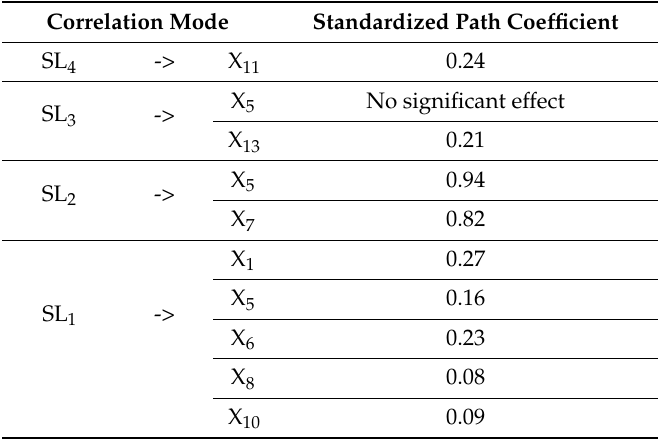
Table 7. Factors’ correlation characters via SEM